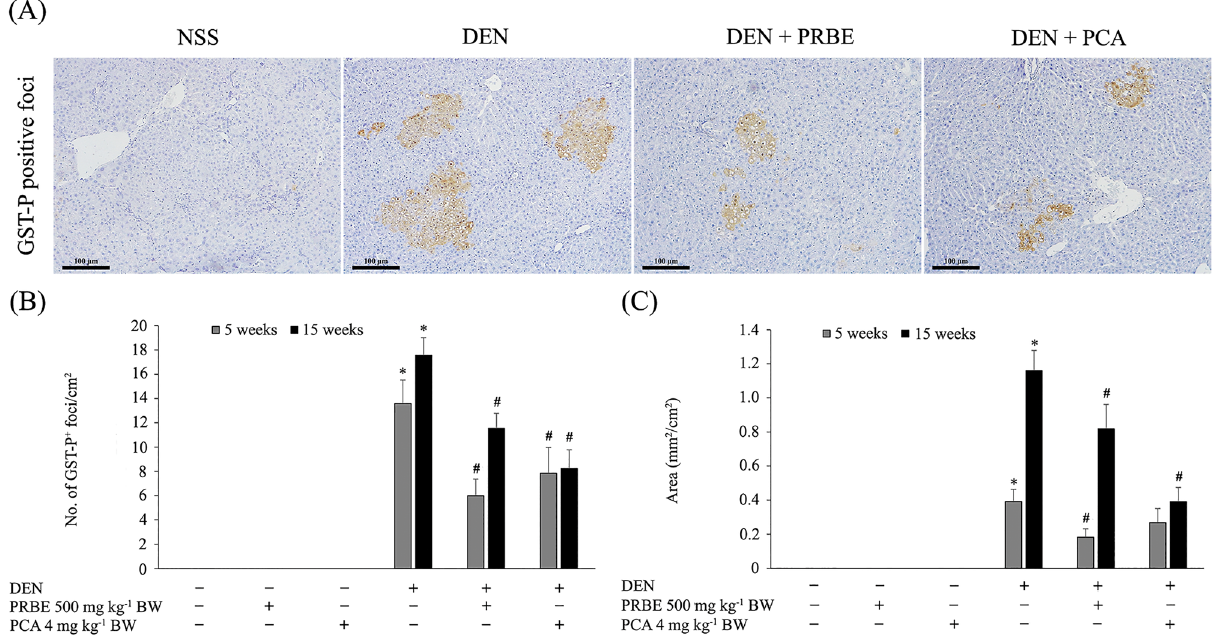
Figure 2. Effect of purple rice bran extract and protocatechuic acid on the number and area of hepatic GST-P-positive foci. ( A ) Immunohistochemical staining of GST-P-positive foci (brown) (20 ×); ( B ) number of GST-P + foci/cm 2 ; ( C ) area (mm 2 /cm 2 ). Values are expressed as mean ± SEM. *Significantly different from the negative control group, p < 0.05. # Significantly different from the positive control group, p < 0.05. DEN: